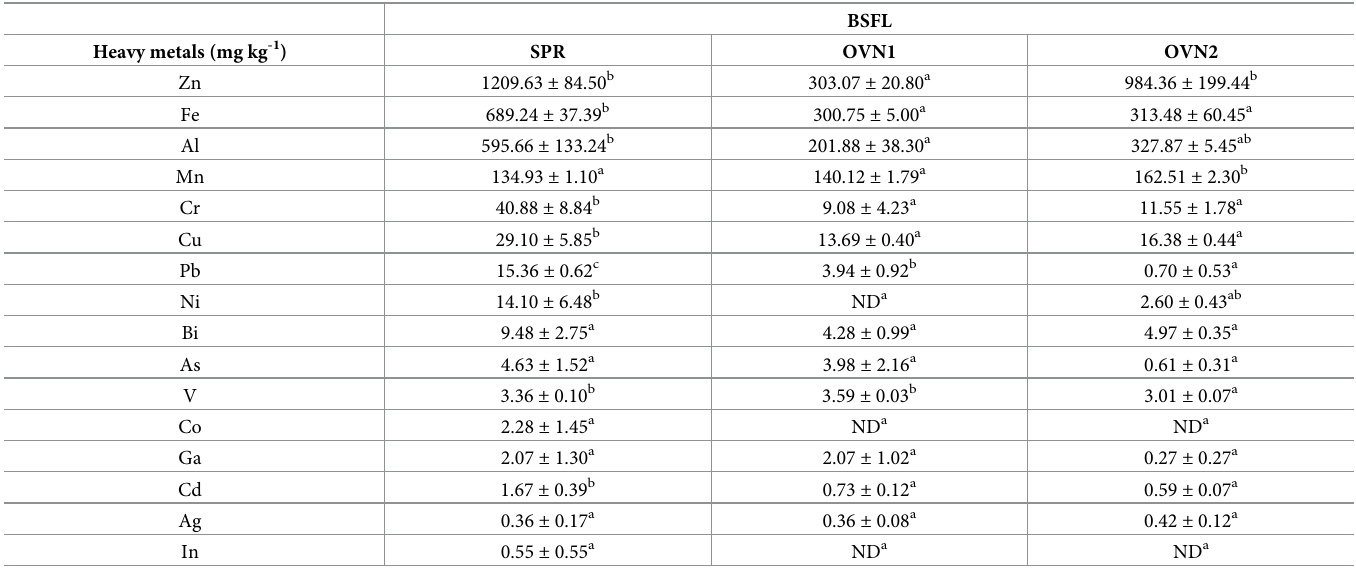
Table 6. Heavy metal composition of three different types of